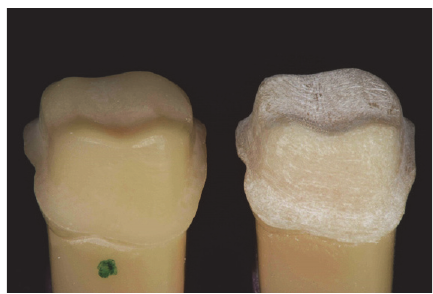
Figure 1: Tooth preparation of Group 2 and Group